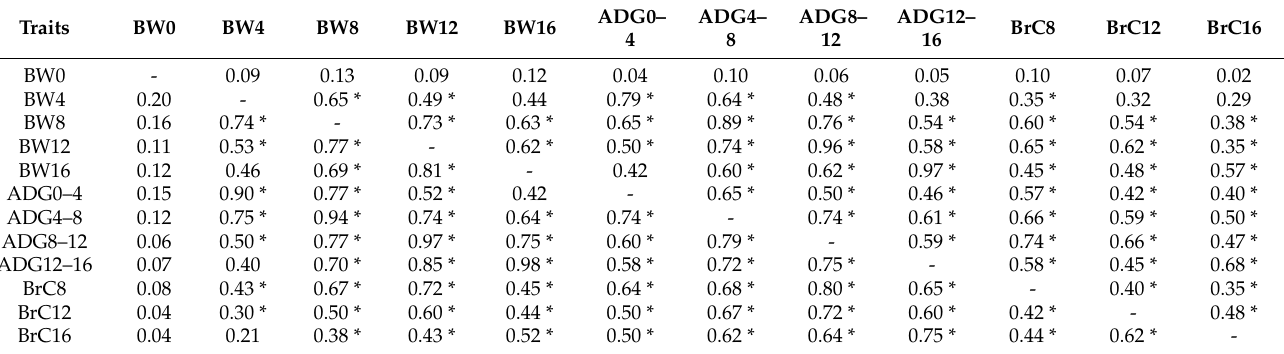
Table 3. Genetic correlations of growth traits between on-site farm (above diagonal) and on-station (below diagonal) Thai native chickens (Pradu Hang